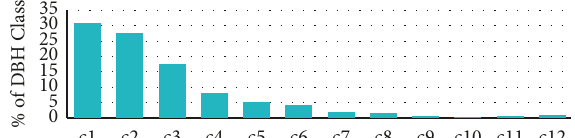
Figure 4: Frequency distribution of trees and shrubs in DBH